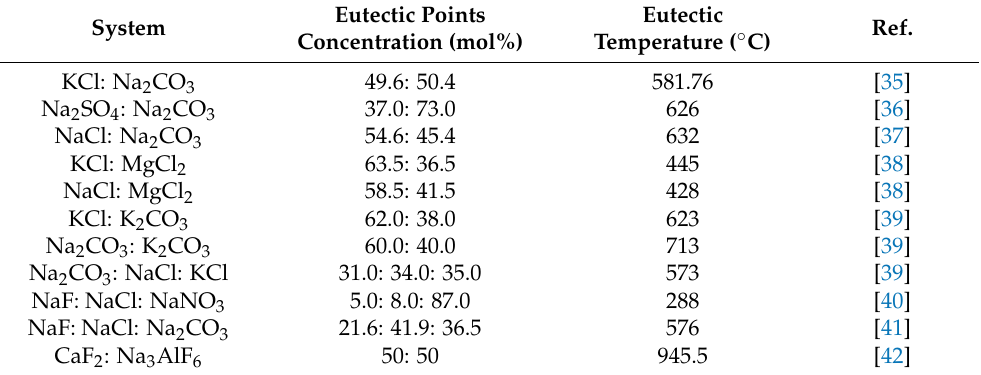
Table 2. The eutectic point compositions and eutectic temperatures of selected commonly used fluxes.